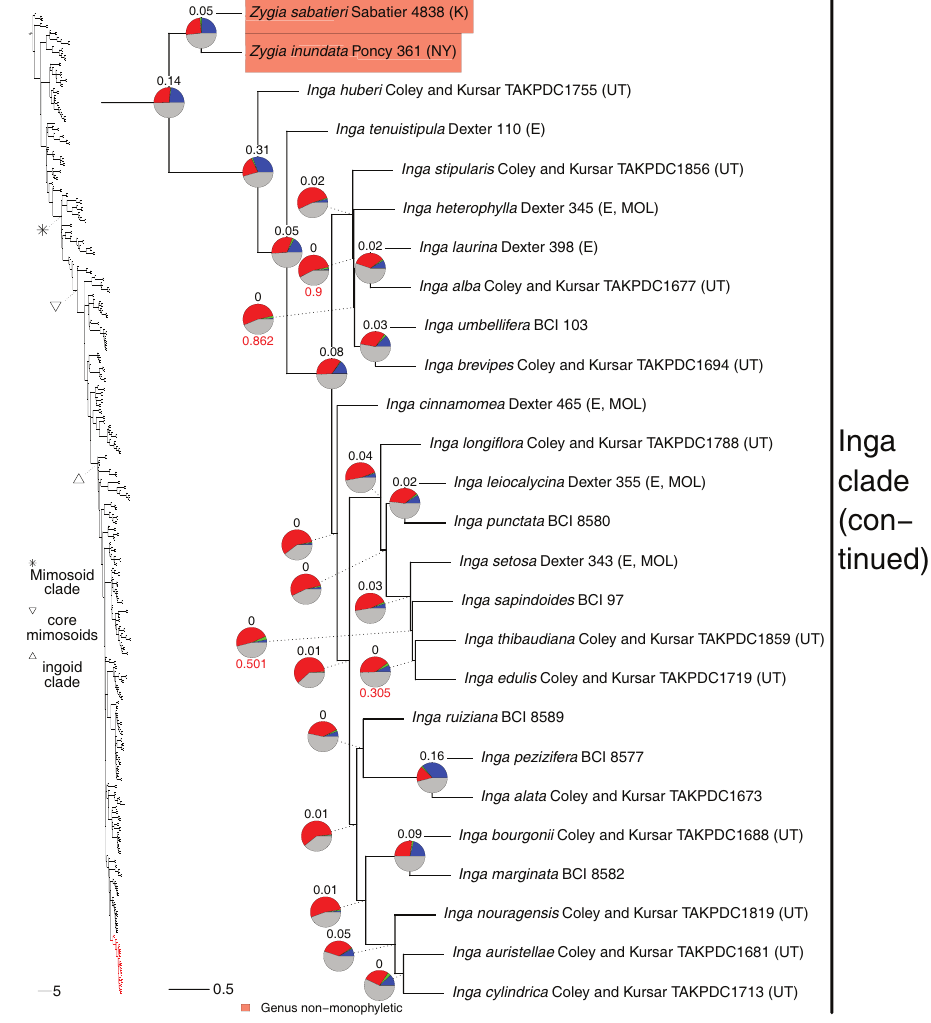
Figure 12. Phylogeny of Caesalpinioideae (continued). See Fig. 2 for